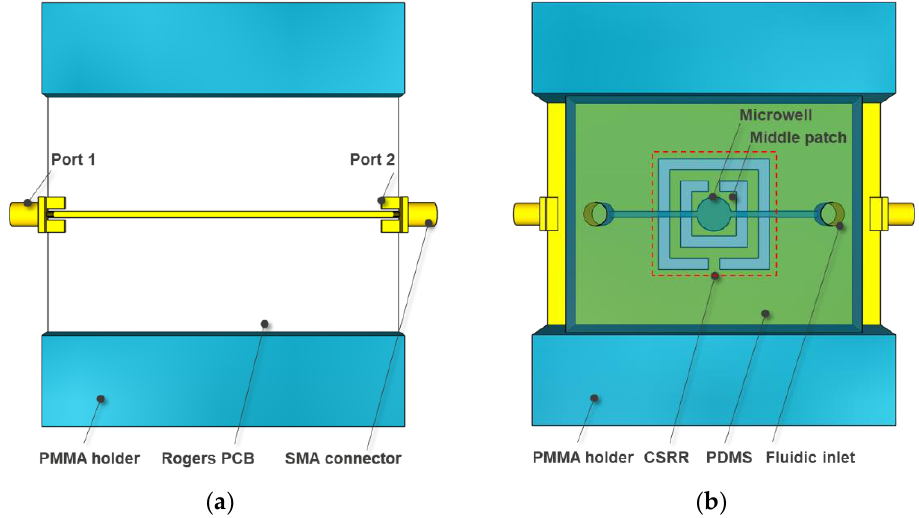
Figure 1. ( a ) A top view of the stack-up with a microstrip transmission line on a PCB with SMA connectors and the top part of a PMMA mechanical holder. ( b ) A bottom view of the stack-up with a CSRR in ground plane that is covered by PDMS with a microfluidic channel and microwell in the middle, and the bottom part of a PMMA mechanical holder.